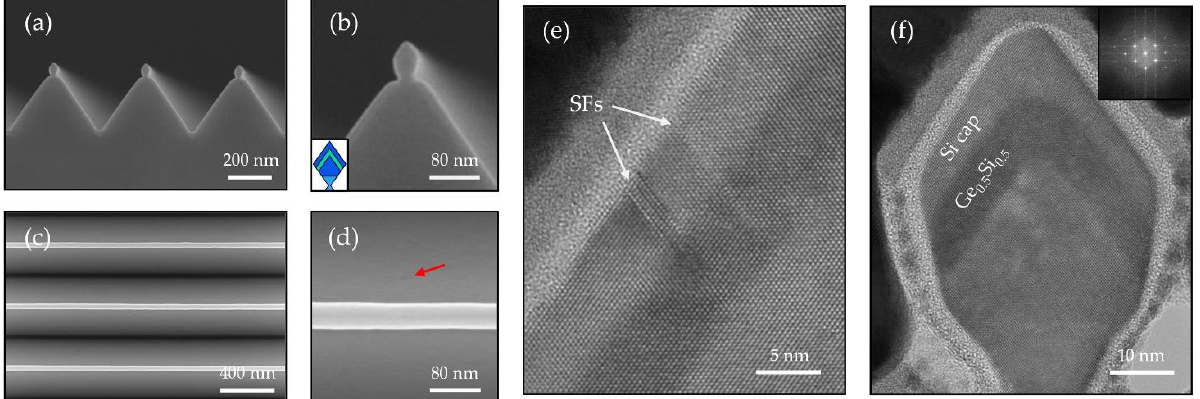
Figure 7. ( a ) Cross-sectional and ( c ) top view SEM images of the Si 0.5 Ge 0.5 NW array and ( b , d ) the corresponding zoom-in images. The brighter contrast presenting in ( b ) results from the Si 0.5 Ge 0.5 layer, where highlights in green in the schematic inset. The red arrow in ( d ) points to a strain-induced defect at the V-groove area. ( e ) Cross-sectional TEM image of SiGe at the V-groove area, showing that stacking faults (SFs) are generated from the interface and penetrate to the surface along the {111} gliding plane. ( f ) Cross-sectional HRTEM of a Si 0.5 Ge 0.5 NW. Inset: FFT analysis of the SiGe/Si NW, showing a single set of spots indicating the SiGe is under fully strained condition.